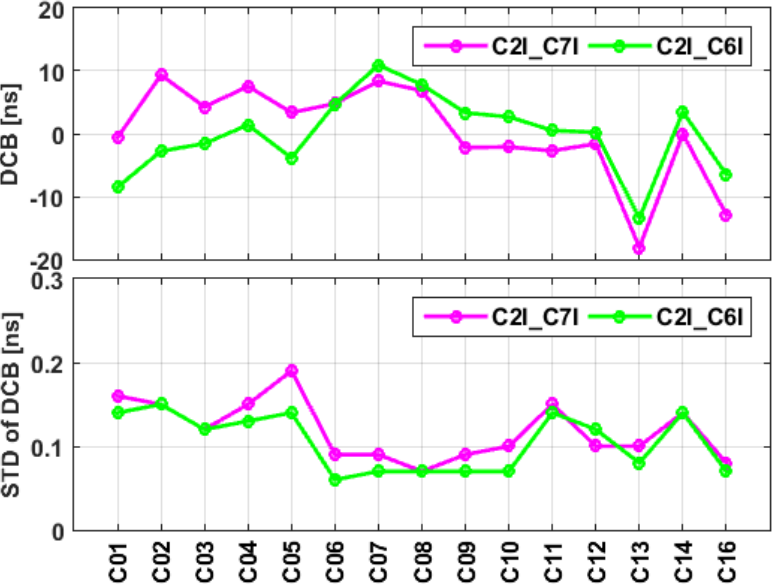
Figure 10. Mean values and monthly stability of the BDS2-based DCB estimates for August 2020.